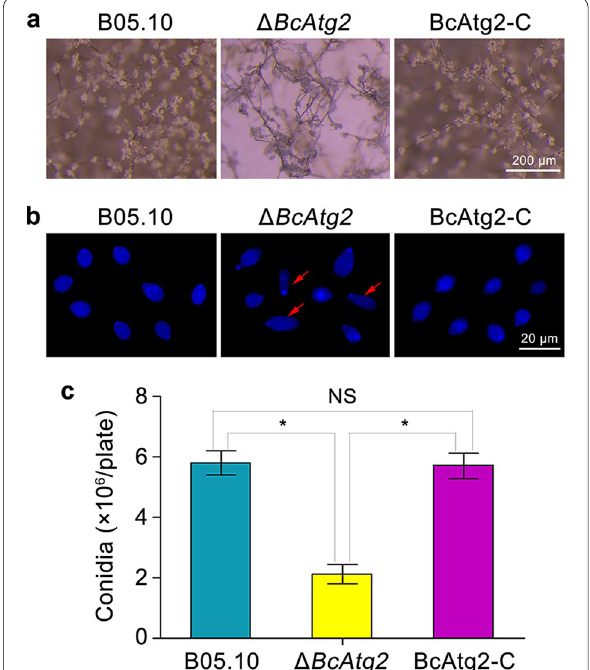
Fig. 5 BcAtg2 is crucial for conidiation in B. cinerea . a Conidia on conidiophores of the wild-type strain B05.10, BcATG2 deletion mutant Δ BcAtg2 and complemented strain BcAtg2-C incubated on sterilized potato fragments at 20 °C under white light for 10 days. b Conidia morphology of each strain. Red arrows indicate abnormal conidia. c Numbers of conidia produced by each strain. Error bars denote standard deviations from three independent experiments, and asterisks indicate statistically significant differences at P =